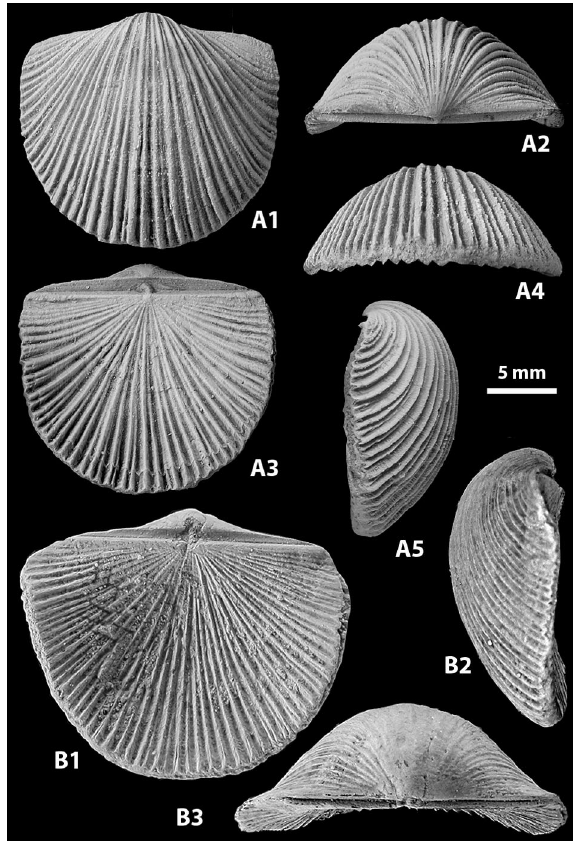
Fig. 1. Cyrtonotella semicircularis (Eichwald, 1829), Popovka, St Petersburg Region (see Popov et al. 2005), Echinosphaerites Limestone, Aseri Regional Stage, Darriwilian. A1 (cid:150) A5 , shell YPM IP 000169A (Schuchert & Cooper 1932, pl. 4, figs 1, 4, 5, 11; Williams & Harper 2000, fig. 537, 4a(cid:150)c), ventral, posterior, dorsal, anterior and lateral views. B1 (cid:150) B3 , shell RM Br 131691, dorsal, lateral and posterior views. Scale bar corresponds to 5